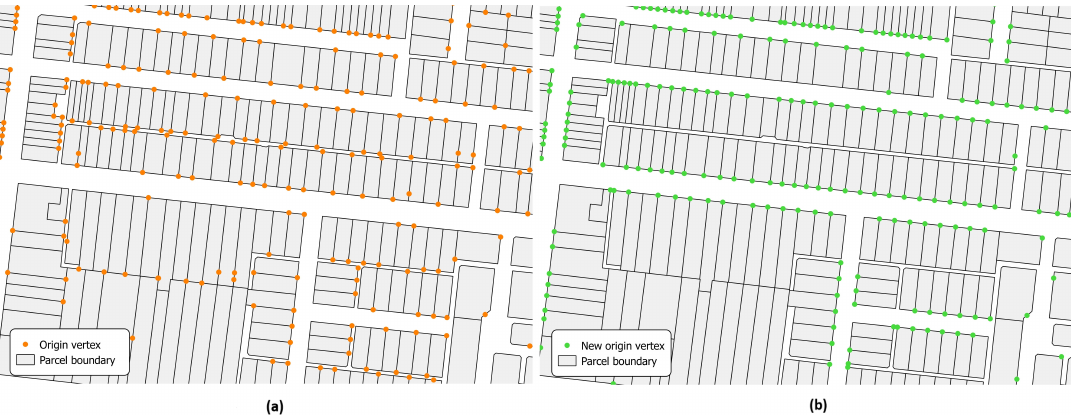
Figure 6. Origin vertex of the parcel view layer: ( a ) prior to application of Street Frontage Script; ( b ) post application of Street Frontage Script.